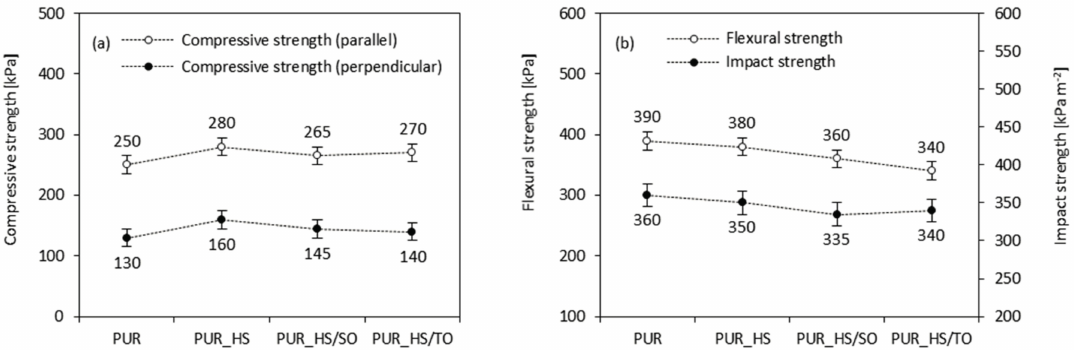
Figure 7. Mechanical characteristics of PUR foams containing HS fillers: ( a ) compressive strength, ( b ) flexural and impact